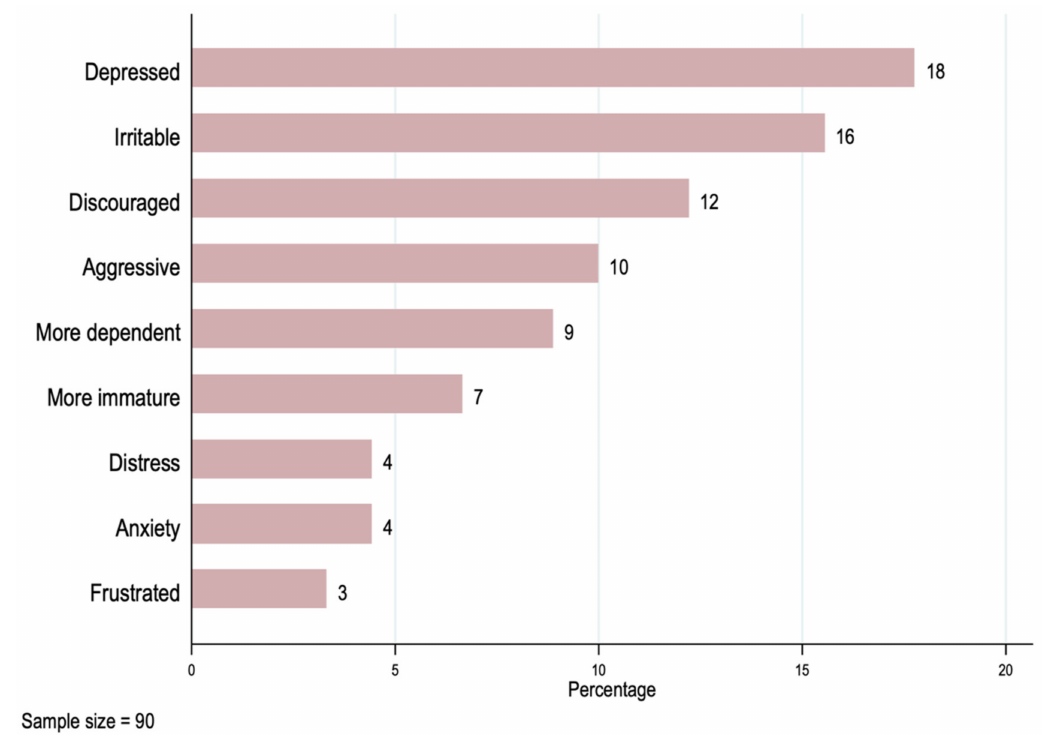
Figure 1. Negative emotional impact on the patient. Table 4. Educational, social, and emotional impacts on the patients’ siblings.